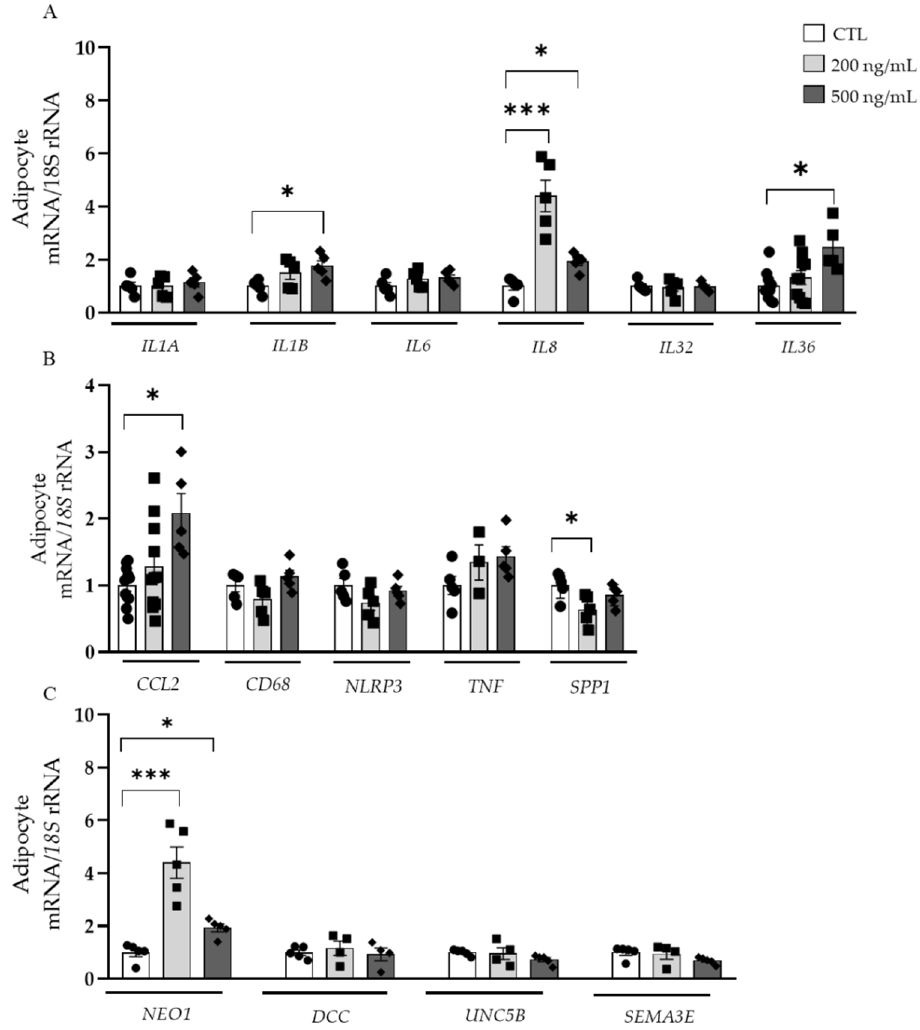
Figure 5. Impact of NTN-1 on the gene expression levels of ( A ) inflammatory interleukins, ( B ) acute inflammatory markers and chemotactic cytokines, and ( C ) NTN-1 receptors and SEMA3E in human visceral adipocytes. Gene expression levels in unstimulated cells were assumed to be 1. Differences between groups were analyzed by one-way ANOVA followed by Dunnett’s post hoc tests. * p < 0.05 and *** p < 0.001. CCL2 , monocyte chemoattractant protein-1; DCC , deleted in colorectal cancer; IL , interleukin; NEO1 , neogenin-1; NLRP3 , NLR family pyrin domain containing 3; NTN1 , netrin-1; SEMA3E , semaphorin 3E; SPP1 , osteopontin; TGFB , transforming growth factor- β ; TNF , tumor necrosis factor- α ; UNC5B, UNC-5 netrin receptor